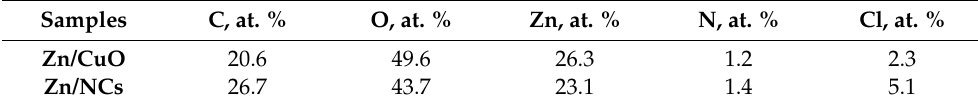
Table 4. Binding energy values of the registered elements in the investigated samples. Samples C, at. % O, at. % Zn, at. % N, at. % Cl, at. % Zn/CuO 20.6 49.6